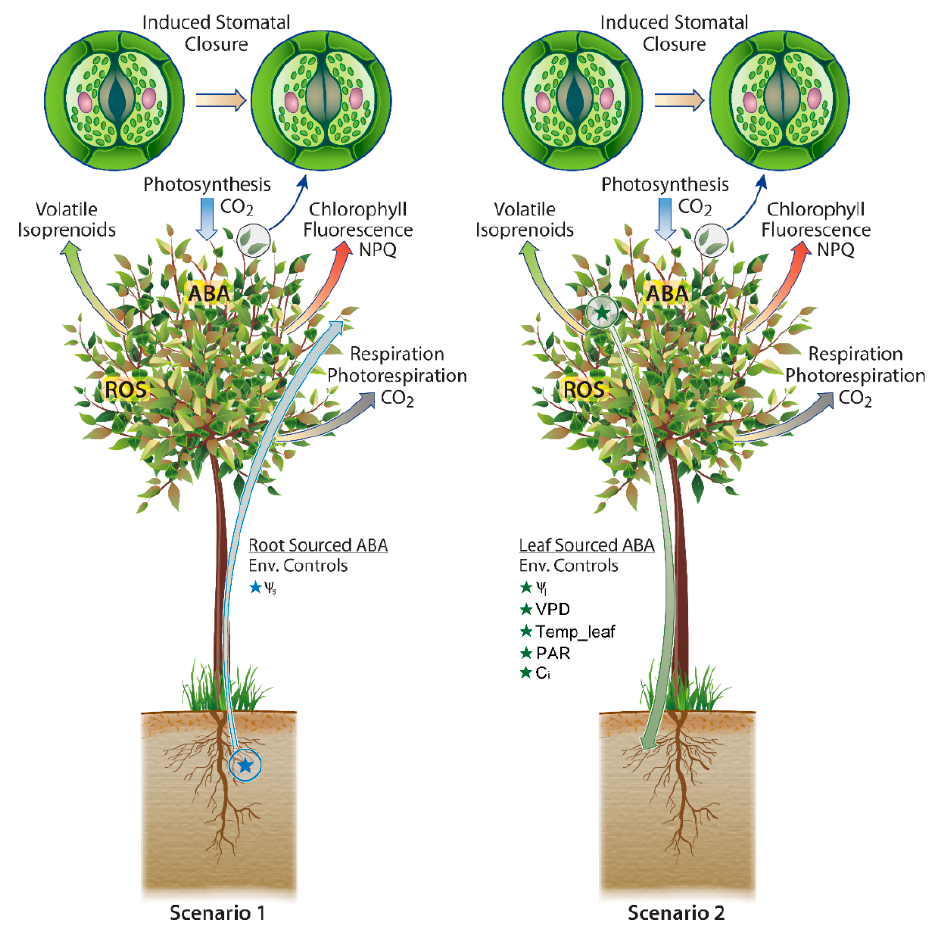
Figure 3. Schematic diagram of two scenarios where ABA mediated plant responses to warming and drought are driven primarily by subsurface processes with environmental controls primarily in soil water potential ( Ψ s ) (Scenario 1) and above ground processes linked with photosynthesis with potential environmental controls including leaf water potential ( Ψ l ), Vapor Pressure Deficit (VPD), leaf temperature (Temp leaf), photosynthetically active radiation (PAR), and leaf internal CO 2 (Ci) (Scenario 2). In Scenario 1, the blue arrow with a star represents root-derived ABA transported to the leaves. In Scenario 2, the green arrow with a star represents leaf-derived ABA transported to the roots. A list of environmental controls influencing ABA biosynthesis are represented underneath the underlined text Root Sourced ABA and Leaf Sourced ABA.